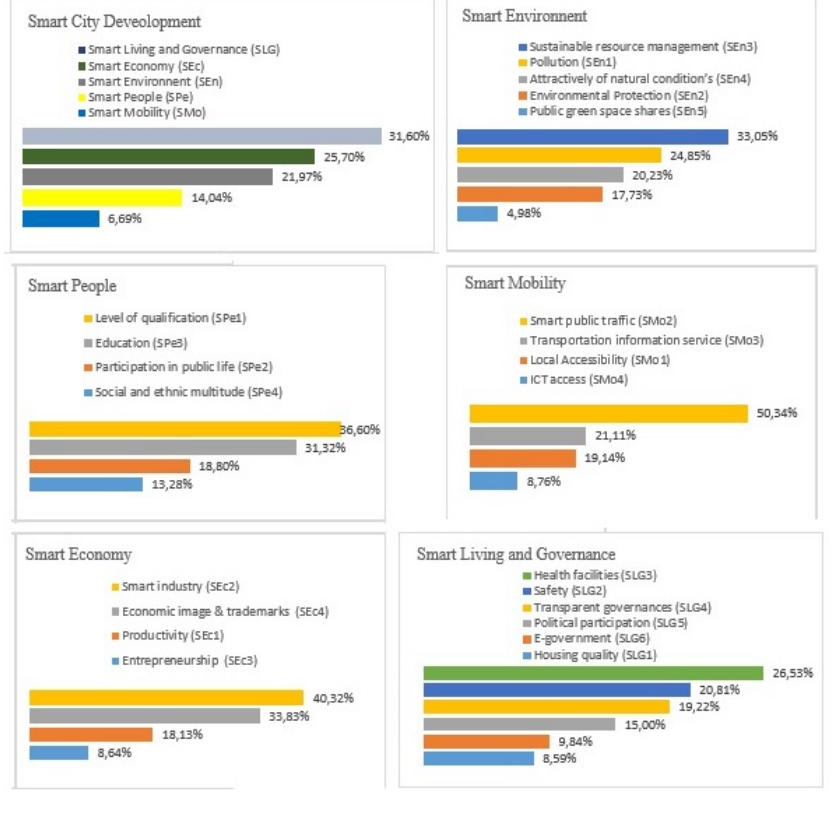
Figure 3. The weight values (%) of the smart city